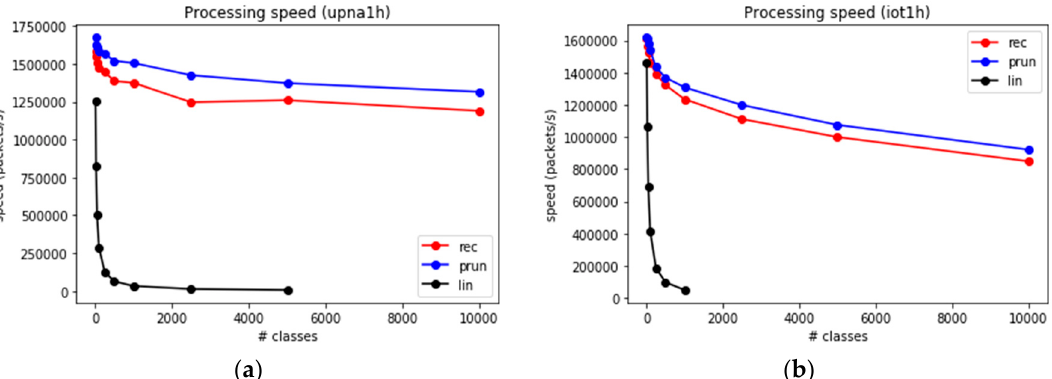
Figure 10. Traffic time series for two minutes ( a ) in the whole trace upna1h, or ( b ) in only one user in trace upna1h.